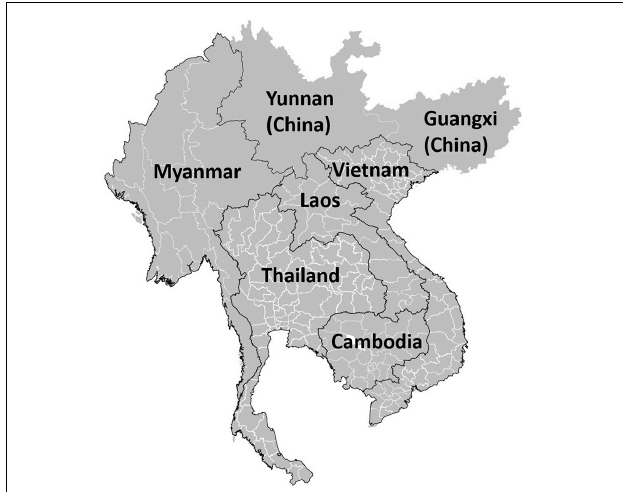
FIGURE 1 | Greater Mekong Subregion (GMS)